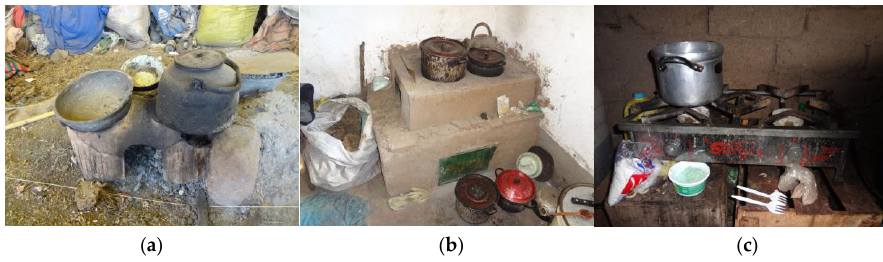
Figure 1. ( a ) Traditional, open-fire, biomass burning stove ( fogón ); ( b ) Locally improved, biomass burning stove (with a chimney on the building’s exterior); ( c ) Liquefied Petroleum Gas (LPG)